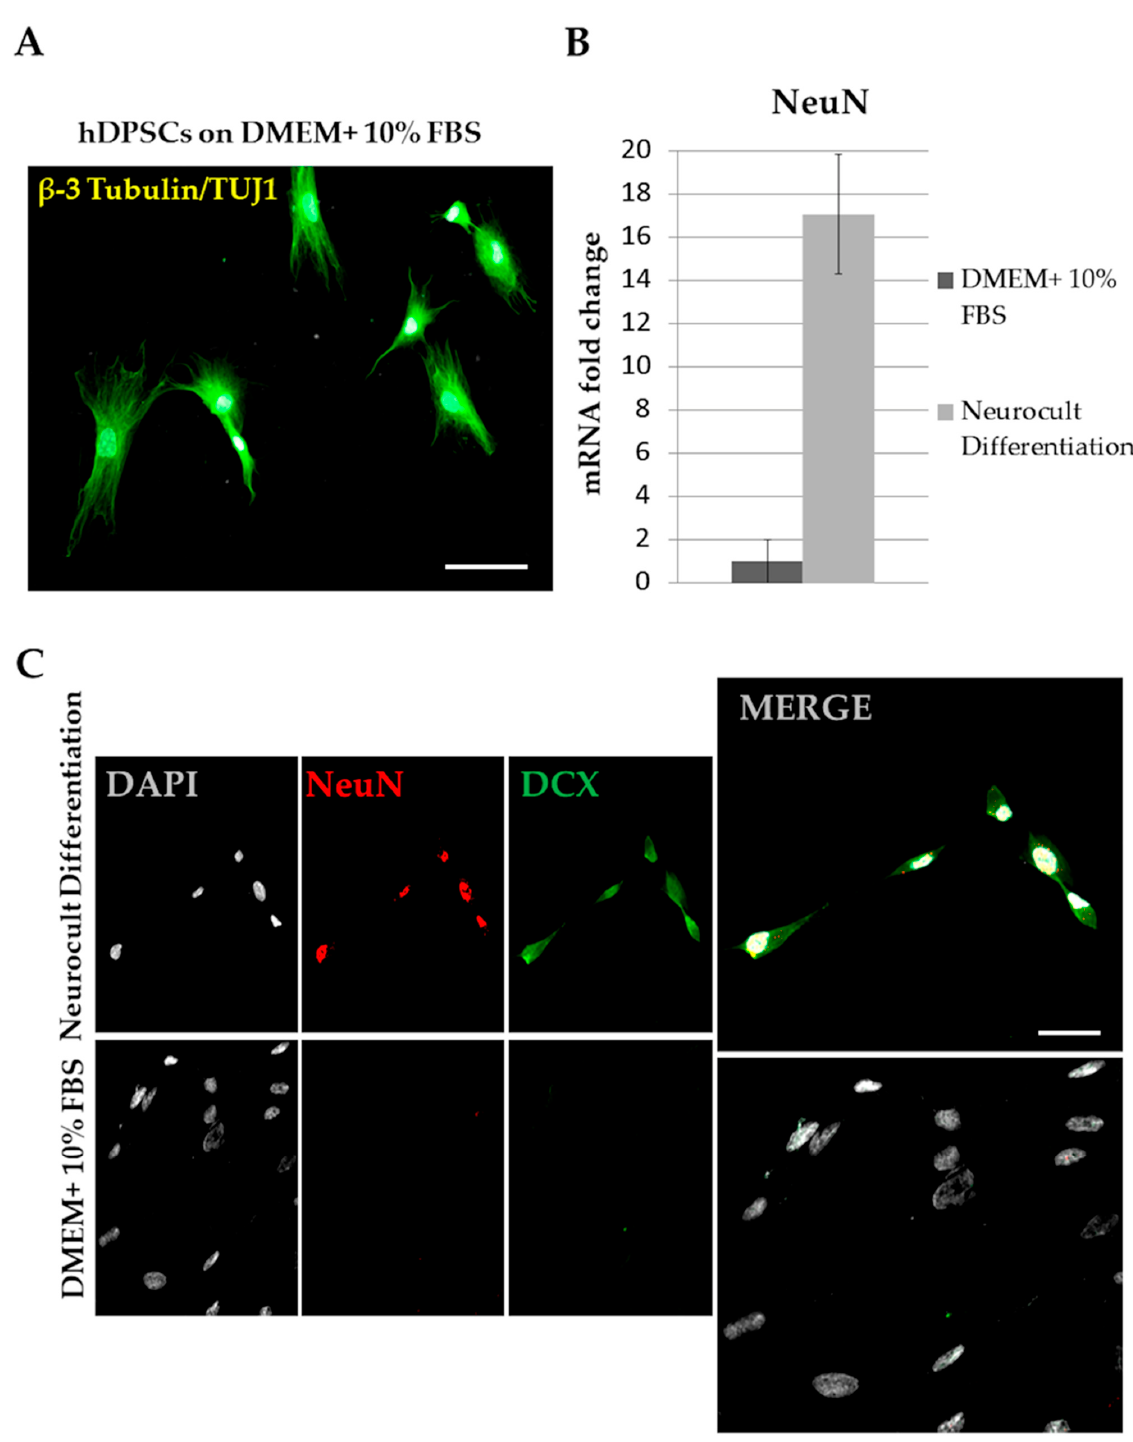
Figure 4. Choosing markers to assess a neuronal-like differentiation of hDPSCs. ( A ) hDPSCs in control non-neural inductive culture conditions still express some mature neuronal markers at high levels, as it is the case of β -3 tubulin/Tuj 1. ( B ) Some other neuronal markers like NeuN are not expressed at all in control conditions, as assessed by qPCR (error bar overlaps with zero Y-axis value on the graph; n = 3). However, when switching hDPSCs from control media to neural differentiation media, NeuN expression rises sharply, by more than 15 × (n = 3). ( C ) Comparison of the expression of the neuronal markers DCX and NeuN, as assessed by IF, for hDPSCs grown in control (DMEM+ 10% FBS) and Neural induction (Neurocult™ differentiation) media. Note the difference of expression of DCX/NeuN between both culture conditions, and the predominantly cytoplasmic staining of DCX with respect to the nuclear staining of